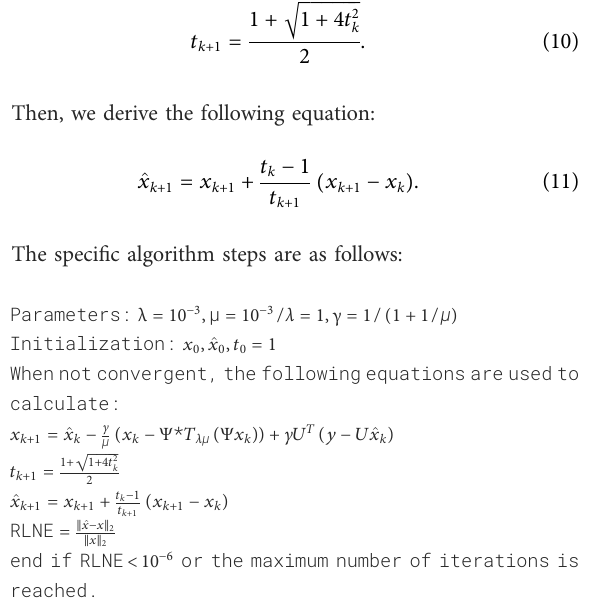
TABLE 2 Reconstruction error and SNR of different methods. FISTA SFISTA Reconstruction error